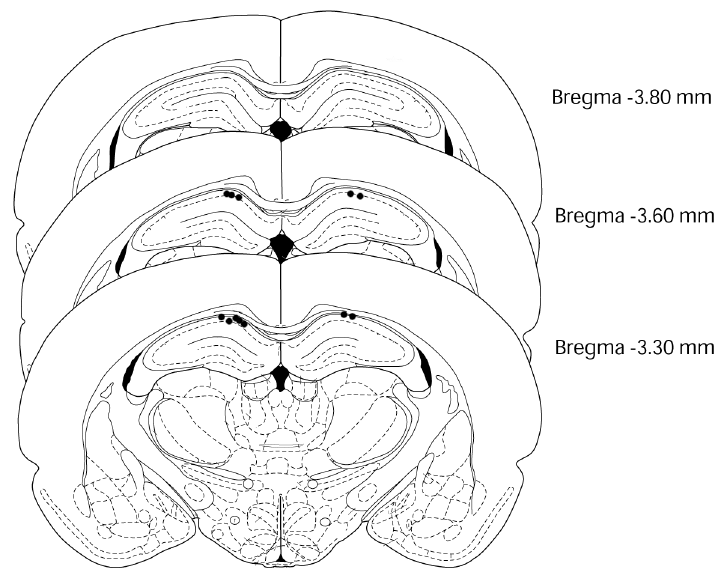
Figure 2. Electrode placements in the rat brains. This figure was modified from “the rat brain in stereotaxic coordinates” of Paxinos and Watson (1997). Black circles indicate the placement of the electrode tips in each rat ( n = 12). doi: